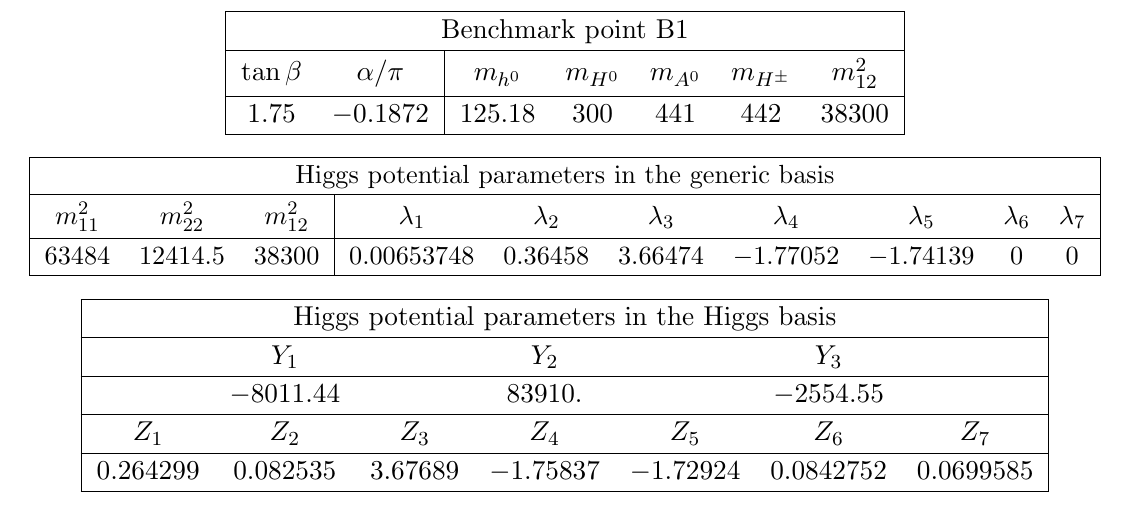
Table 3 . Benchmark point B1 of [37]. The value of the lightest Higgs boson h 0 is updated to the newest PDG value [1]. The vacuum expectation value v 2 = G (cid:0) 1 potential parameters in the generic or in the Higgs basis, is de(cid:12)ned in the same way as in [37], but the value for G F = 1 : 1663787(6) (cid:2) 10 (cid:0) 5 GeV (cid:0) 2 is taken from [1]. The bilinear parameters m 2 Y i are given in GeV 2